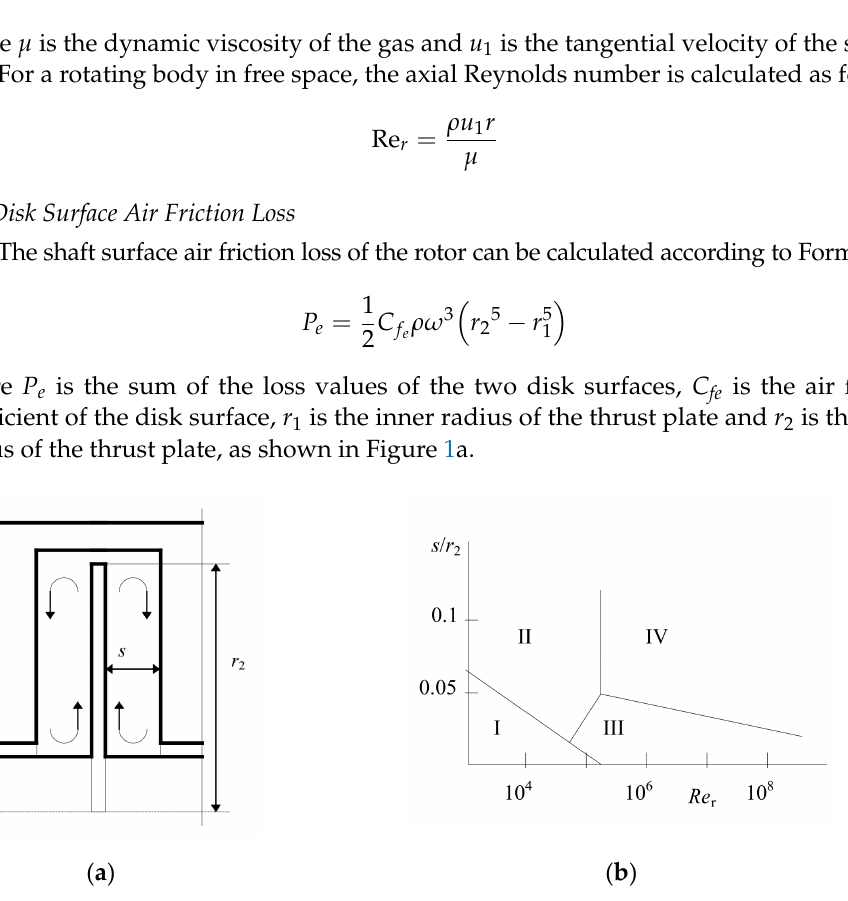
Figure 1. Zoning method of end face wind friction loss calculation. ( a ) Schematic diagram of rotating end face. ( b ) Approximate fluid region division of closed rotating disk.